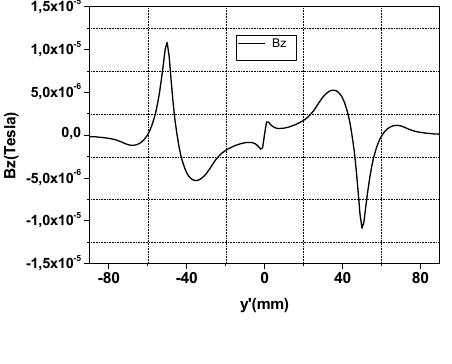
(A) for a width 𝑤 = 1 𝑚𝑚 and for four different